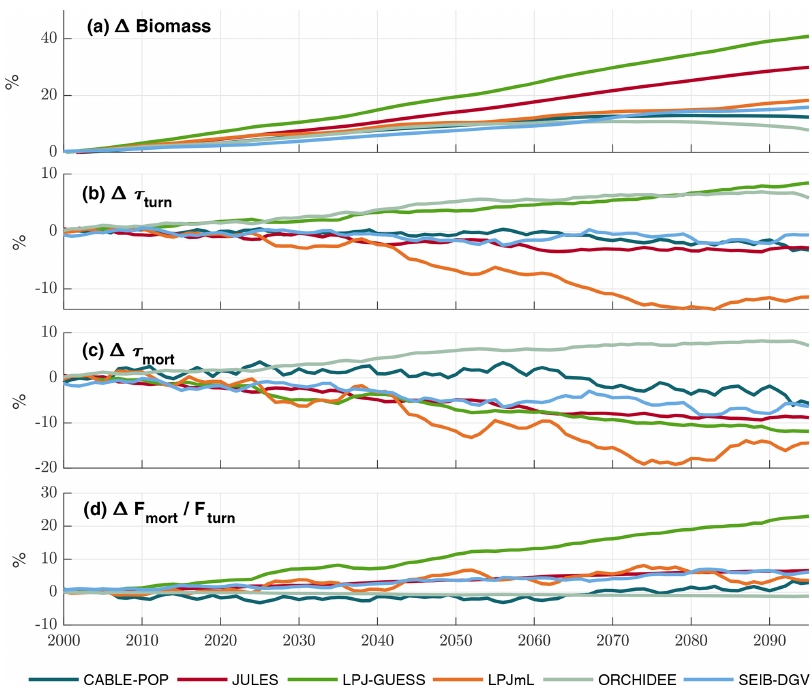
Figure 8. Simulated evolution of carbon residence times in the TBM simulations forced by IPSL-CM5A-LR RCP8.5 bias-corrected climate data. All plots show relative changes compared to a 1985–2014 baseline. (a) C veg . (b) τ turn ( C veg /F turn ). (c) τ mort ( C veg /F mort ). (d) Change in fraction of total turnover due to mortality ( F mort / F turn ). Results are shown as an 11-year running mean.